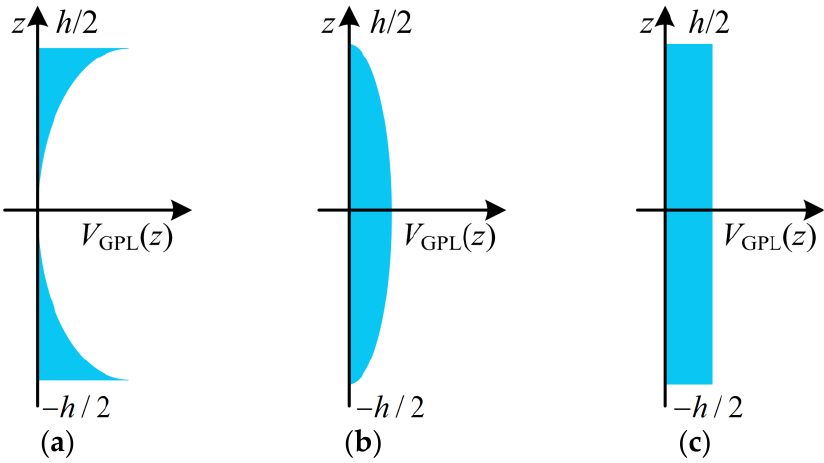
Figure 3. Three types of GPL distribution patterns. ( a ) GPL A; ( b ) GPL B; ( c ) GPL C.